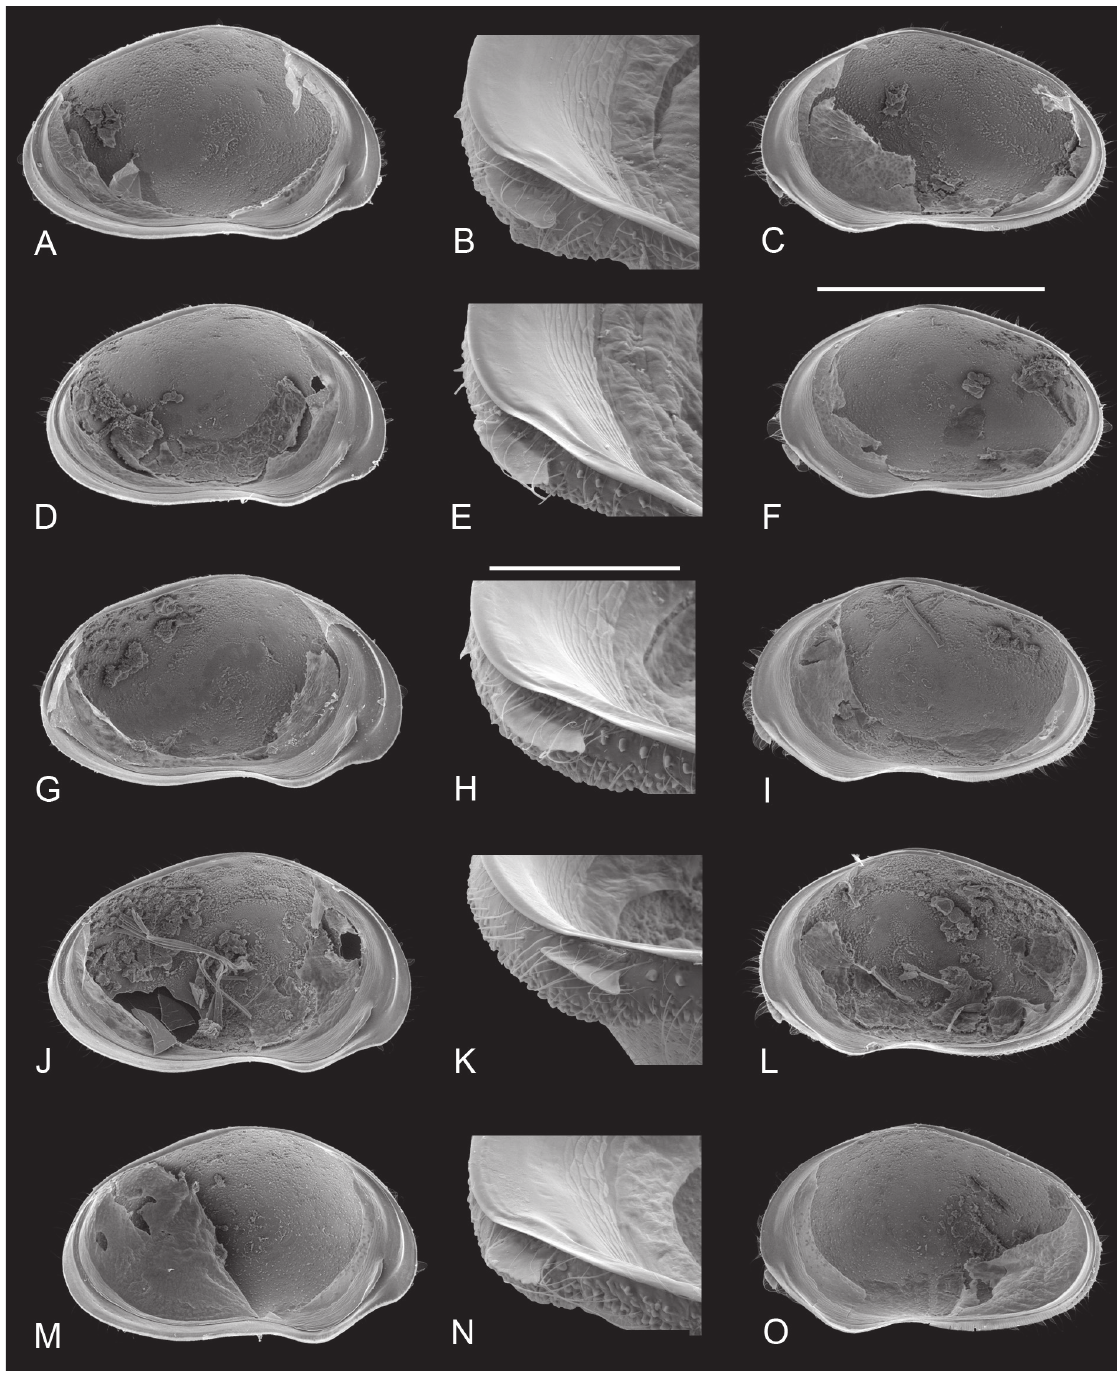
Fig. 6. Bennelongia timmsi sp. nov., all represent females with molecular data available. — A-C